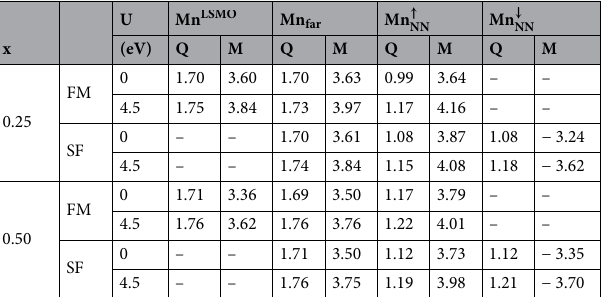
Table 2. Mulliken population analysis for x = 0.25 , 0.50. Mn NN are the nearest neighbors to the oxygen vacancy and Mn far refers to a Mn atom far away from the defect. Mn the pristine system. Q (e) represents the valence charge and M ( µ B ), the